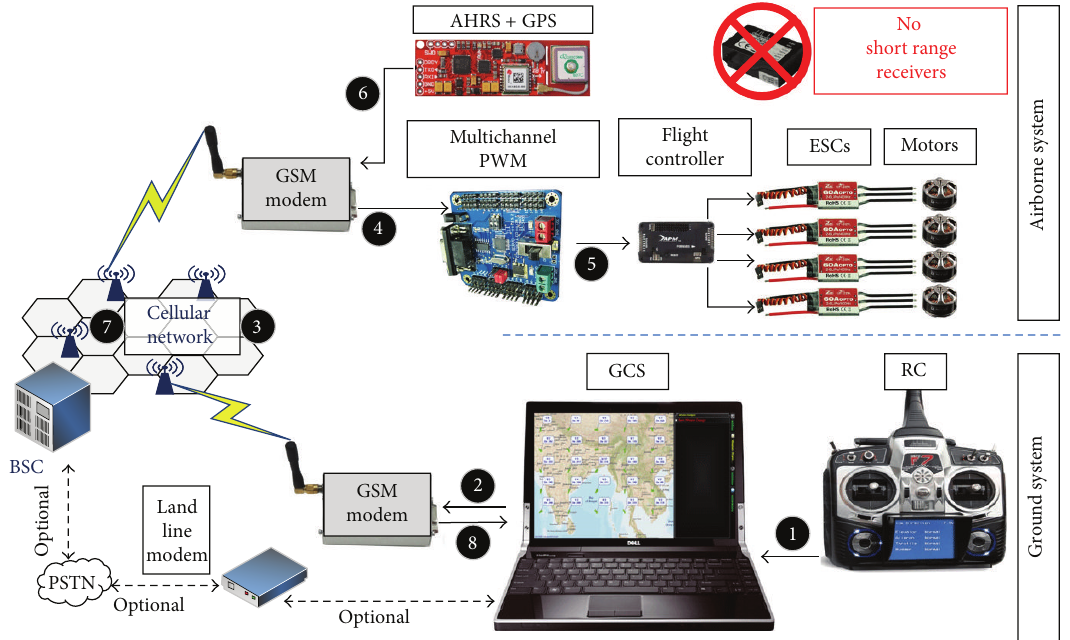
Figure 5: Proposed control and communication